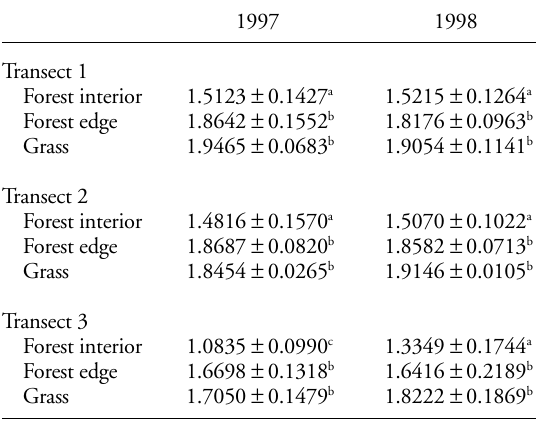
Table 2 . Average Shannon diversity of carabids per trap (with SD) in the studied habitats. Means with different letters indicate a significant (p<0.05) difference by Tukey-type multiple comparison.